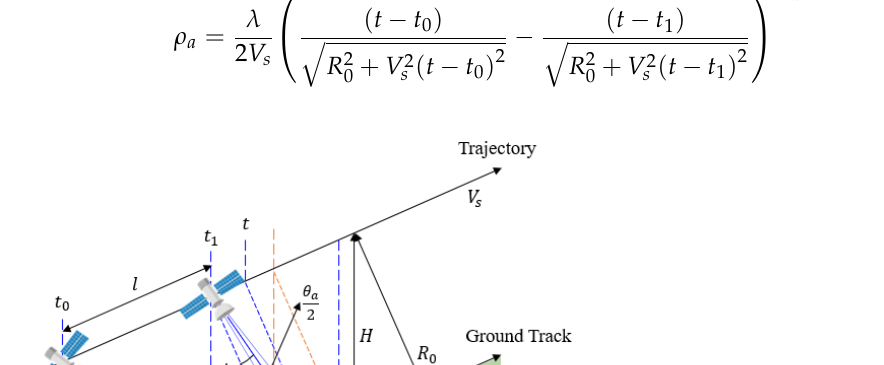
scene to be imaged. Figure 5. Illuminated geometry of broadside sliding spotlight SAR.